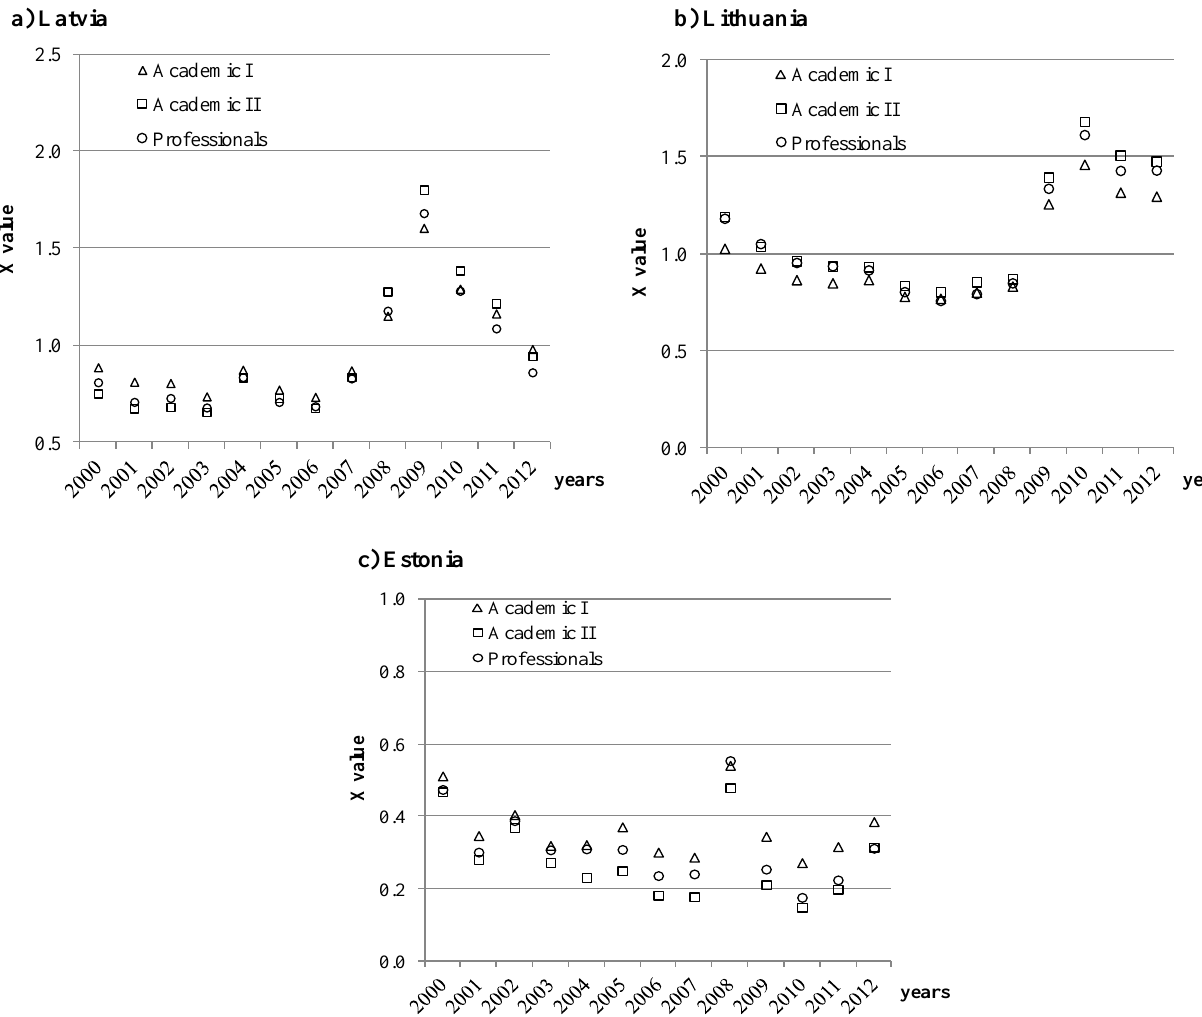
Fig. 2. Values of the consolidated indicator of the state financial stability for the Baltic States calculated using weight coefficients from different expert groups.